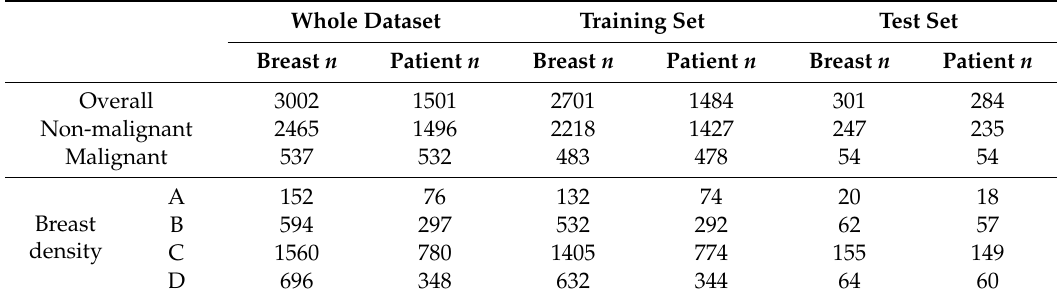
Table 1. Data composition for digital mammograms in the training and testing